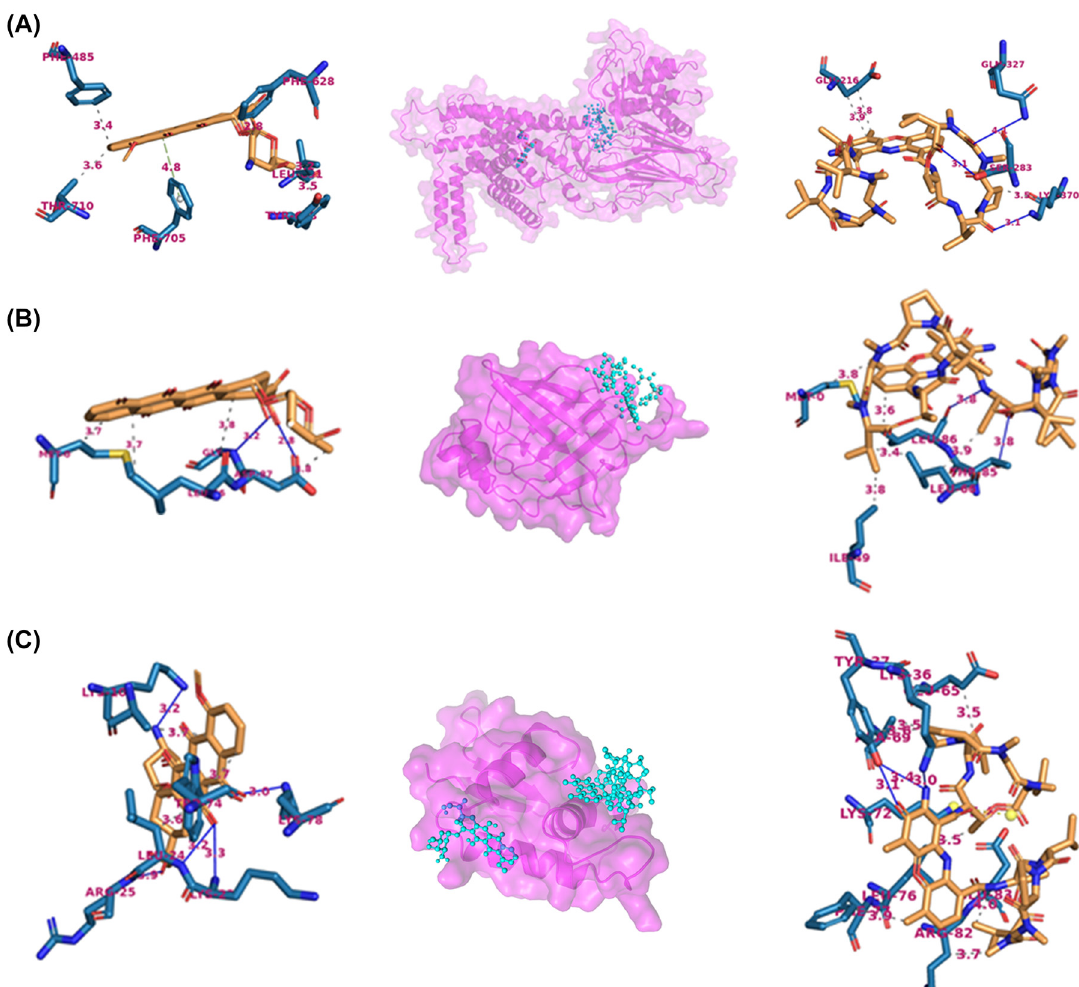
Figure 7: The interactions that established after docking the drugs, adriamycin (left of the protein drug complex) and actinomycin (right of the protein drug complex) against the three target proteins: (A) ADGRG7, (B) FABP4 and (C) IRF4. Protein is represented in ribbon (magenta color) and ligands are shown in ball stick model. Hydrophobic Interaction are shown by dashed lines and Hydrogen Bond are shown by blue densed lines.